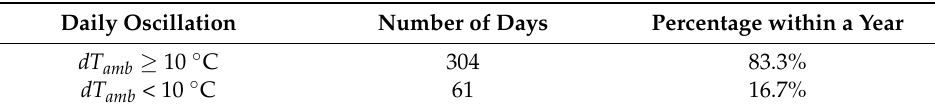
Table 1. Number of days with ambient temperatures higher or equal to 10 ◦ C oscillations within a typical Mexico City climatic year as well as the mean annual temperature oscillation, where T amb corresponds to the outdoor ambient